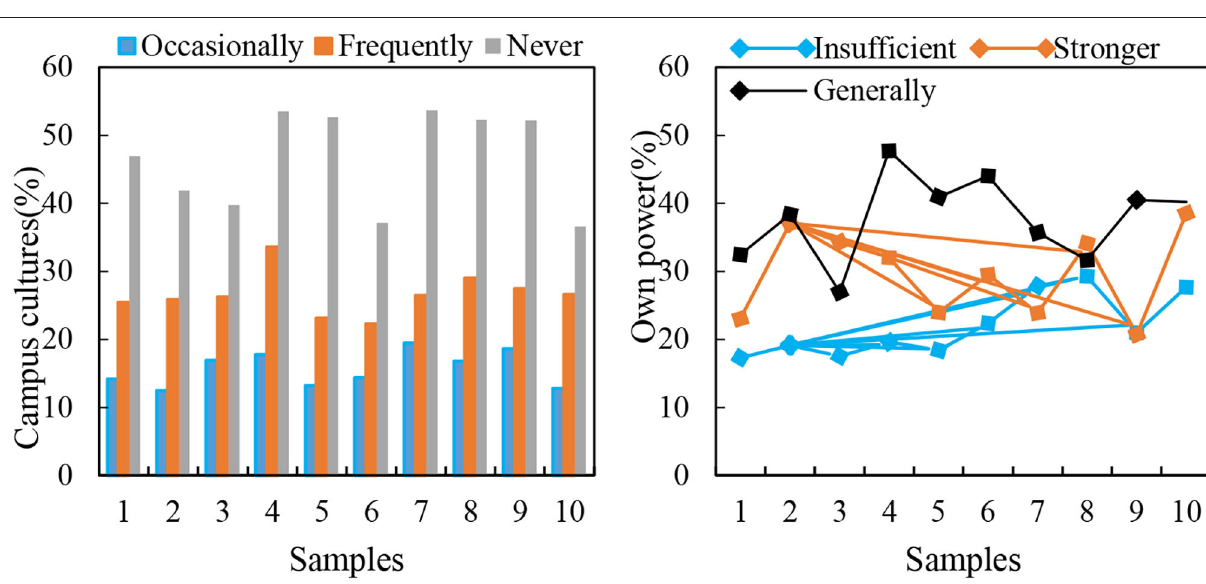
FIGURE 8 | On abilities and participation in campus cultural